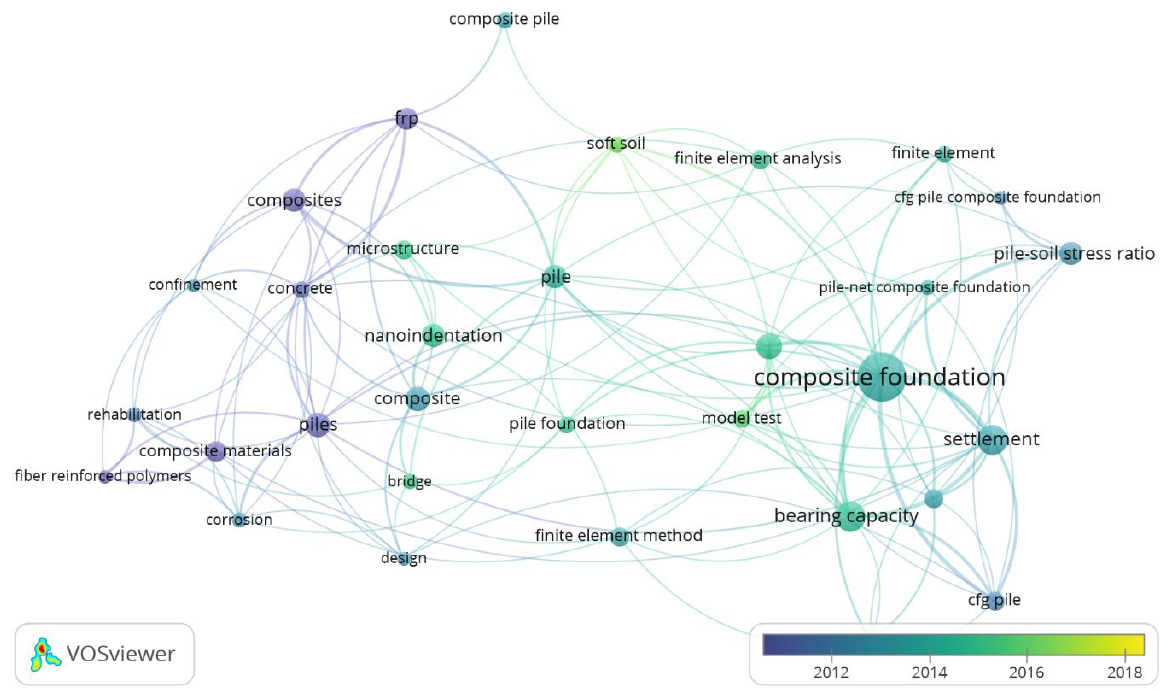
Figure 5. Visualization of frequently used keywords.